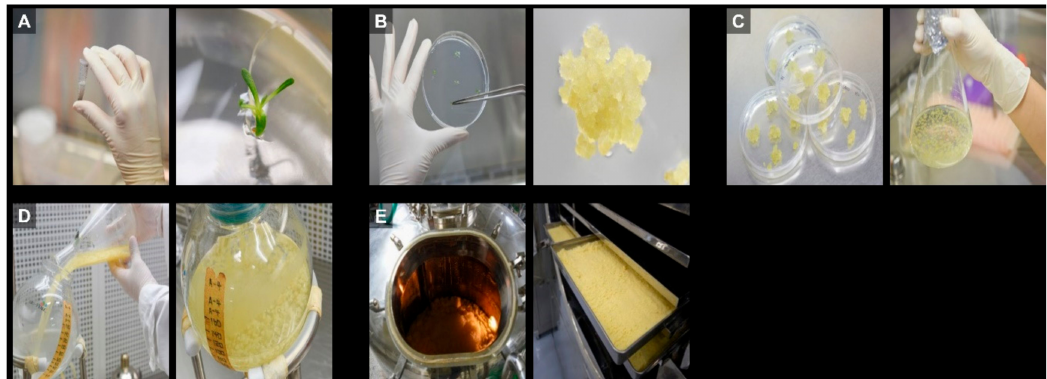
Figure 1. Experimental procedure to obtain Leontopodium Alpinum callus culture extract (LACCE) from edelweiss callus using a bioreactor. ( A ) Edelweiss seeds were sterilized and germinated. ( B ) Callus was induced from edelweiss leaf tissue. ( C ) Induced callus was suspension cultured. ( D ) Obtained cells were cultured in a bioreactor. ( E ) Callus cells were harvested and lyophilized in a large